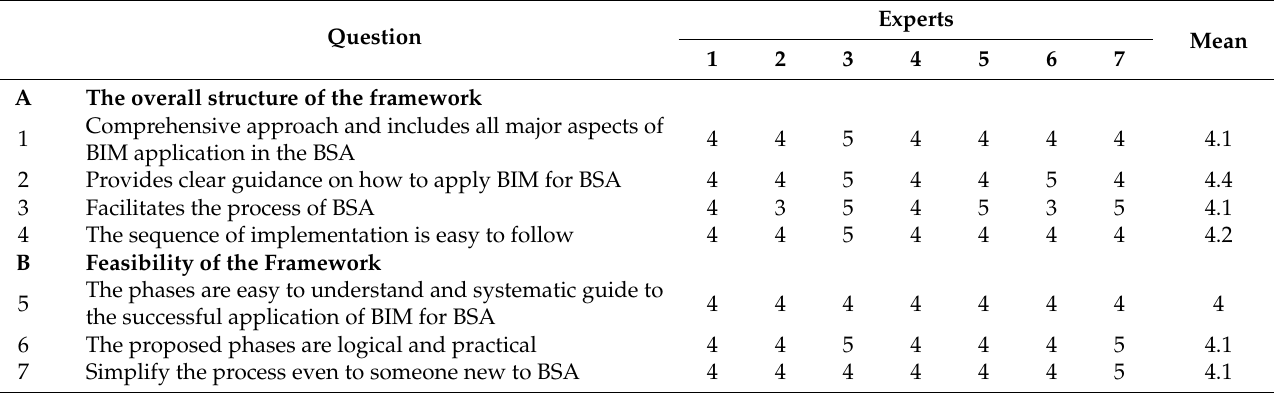
Table 7. Results of Delphi round